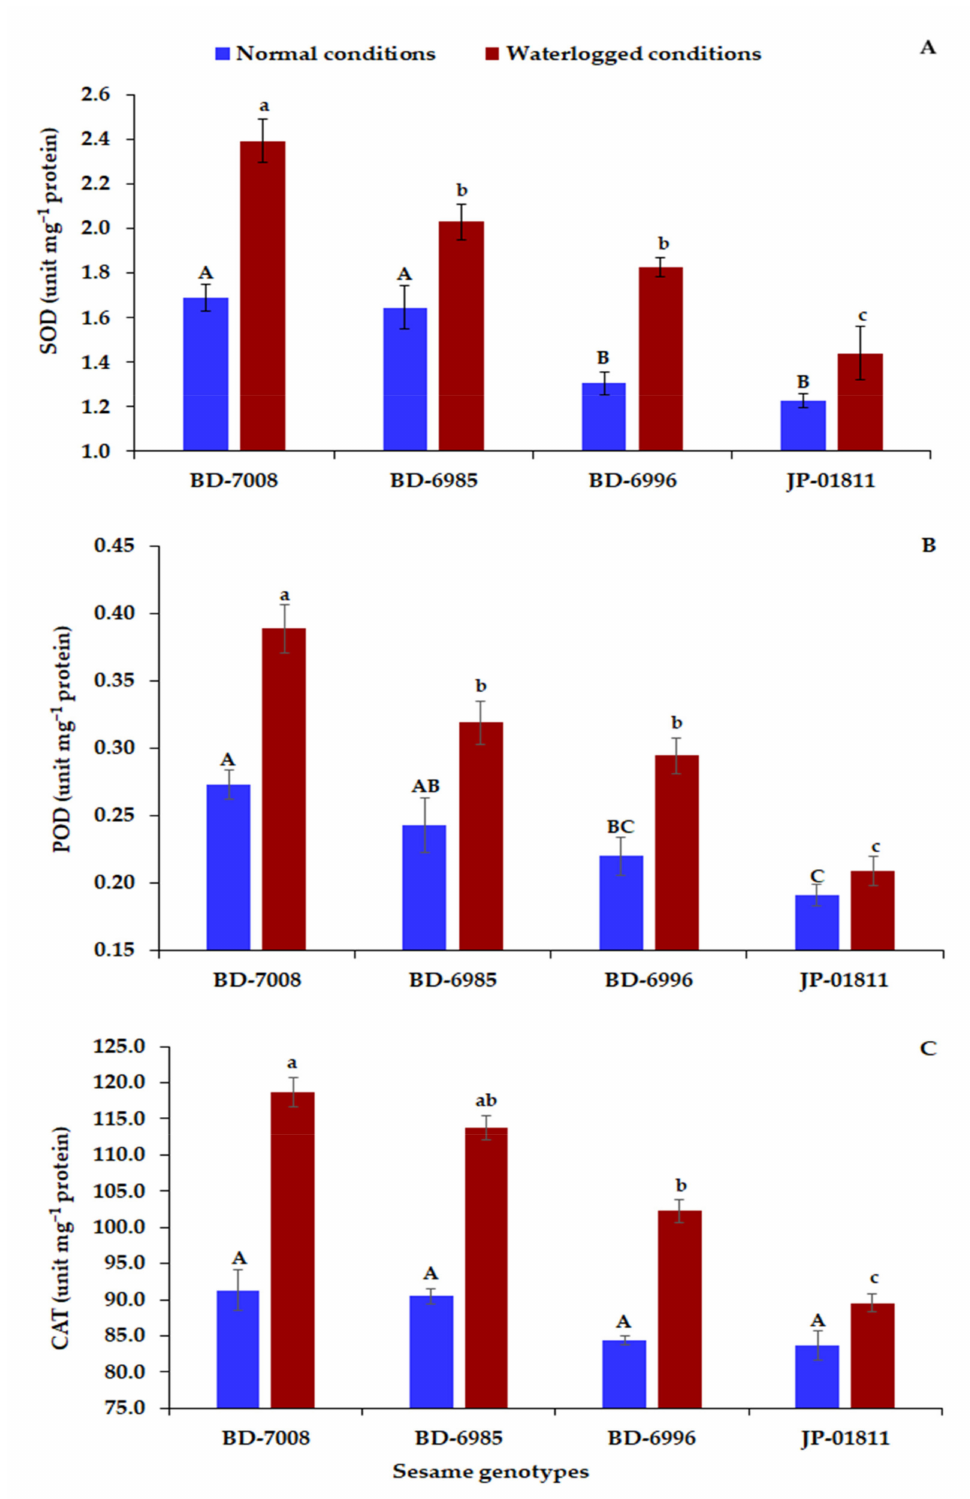
Figure 4. Impact of 48 h of waterlogged conditions on the activities of superoxide dismutase activity (SOD) ( A ), peroxidase (POD) ( B ), catalase (CAT) ( C ), and of four sesame genotypes. The bars on the columns correspond to SE and different uppercase letters indicate significant differences by LSD ( p < 0.01) under normal conditions, while lowercase letters indicate waterlogged